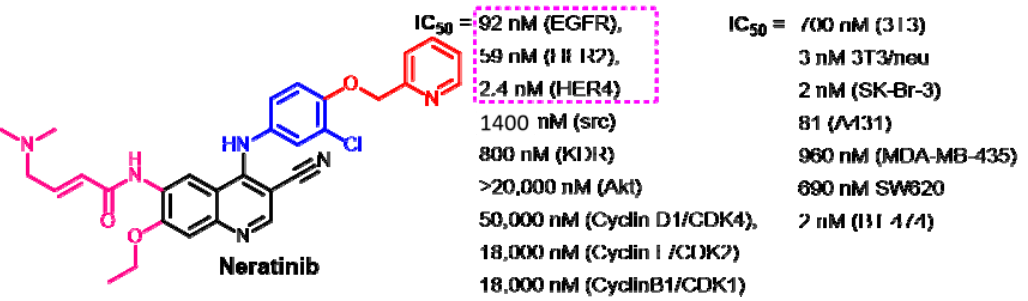
Figure 44. Kinase inhibitory activities of neratinib against selected kinases and cancer cell lines.